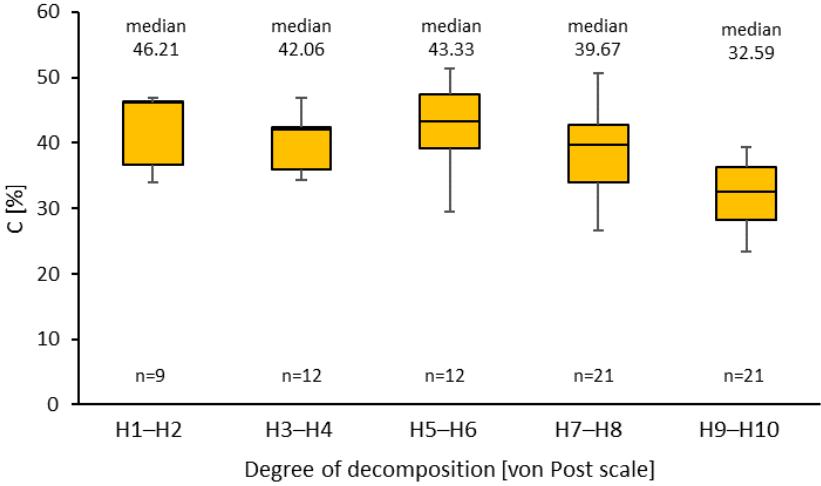
Figure 3. Organic carbon content versus degree of decomposition of the investigated soil profiles. Boxplot showing median, interquartile range, minimum and maximum of organic carbon content versus degree of decomposition.